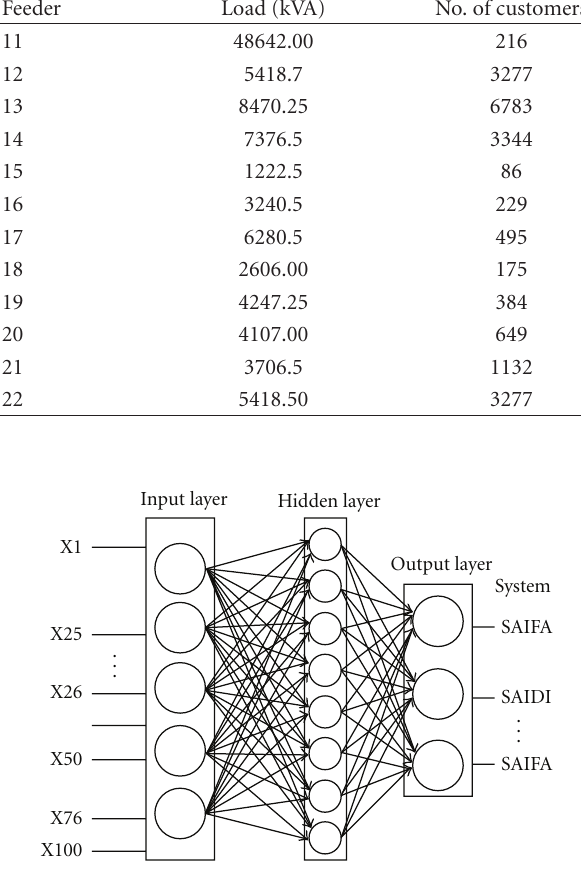
Figure 1: Structure of neural network.